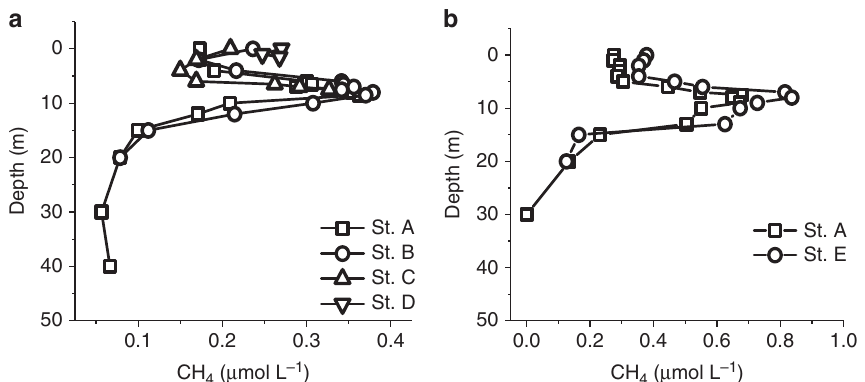
Fig. 3 Dissolved CH 4 spatial heterogeneity in Lake Hallwil. Water column dissolved CH 4 pro fi les carried out within few hours on a 10 June 2015 from the east shore toward the center of the lake at stations A, B, C, D (45, 40, 20, 2 m lake depth, respectively) and b on 21 August 2015 from center (St. A) toward south (St. E, 20 m lake depth). See Supplementary Fig. 1 for sampling locations